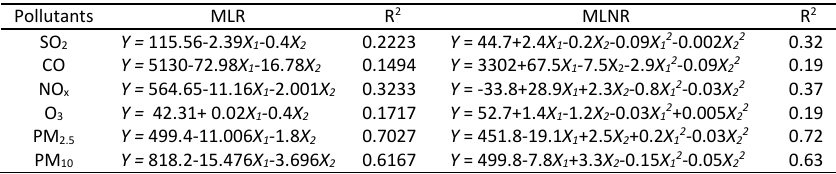
Here, Y= the concentration of pollutants, X1 = Temperature and X2 = Relative humidity